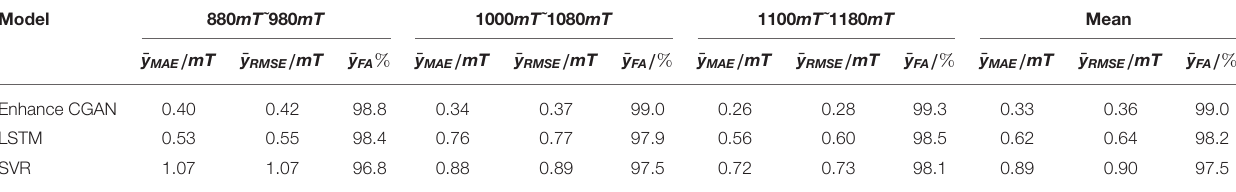
TABLE 6 | Comparison of prediction error and precision under different magnetization conditions (7 m / s velocity).